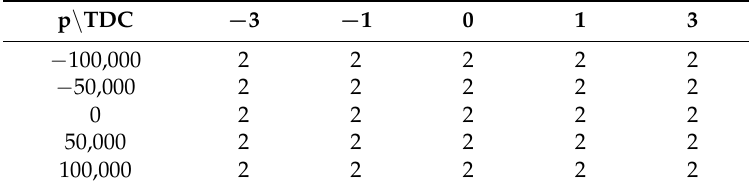
Table B4. Number of iterations for the PSA engine and operating point 2000 1/min and 20 Nm using the off-line method. p \